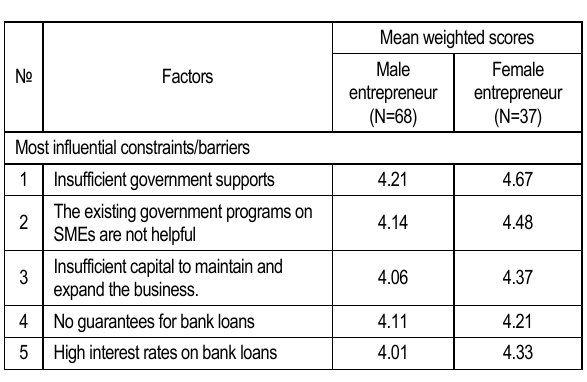
Table 3. Constraints to entrepreneurship development and